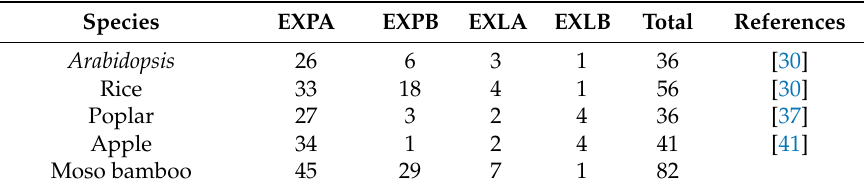
Table 1. Number of expansin genes in five plant